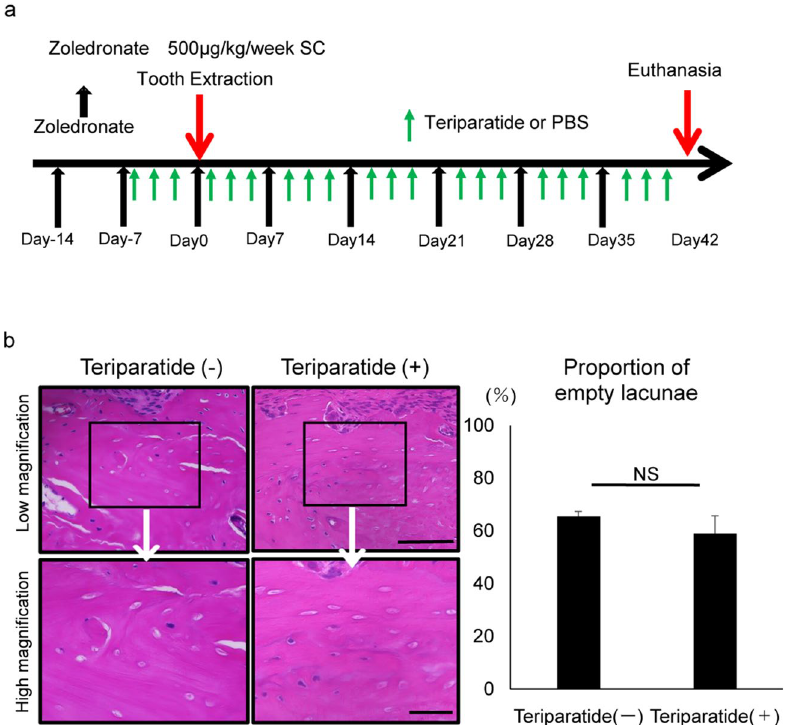
Figure 8. Osteonecrosis development is not effectively blocked by teriparatide. C57BL/6 mice were administered zoledronate for 2 weeks. PTH (80 μg/kg) or PBS was intraperitoneally injected twice a week for 2 weeks before extraction and afterwards twice a week. One week after the first injection when mice were 10 weeks old, the right first and second molars in mandible were extracted. Six weeks after extraction, mandibles were removed, stained with HE, observed microscopically ( a ), and the proportion of empty versus whole lacunae was calculated ( b ). Scale bars = 100 (upper) or 20 μm (lower panels). Data shows the mean percentage (%) of empty versus whole lacunae ± SD ( n = 5 each, NS, not significant). Representative data are shown of at least two independent and identical experiments, each with n =